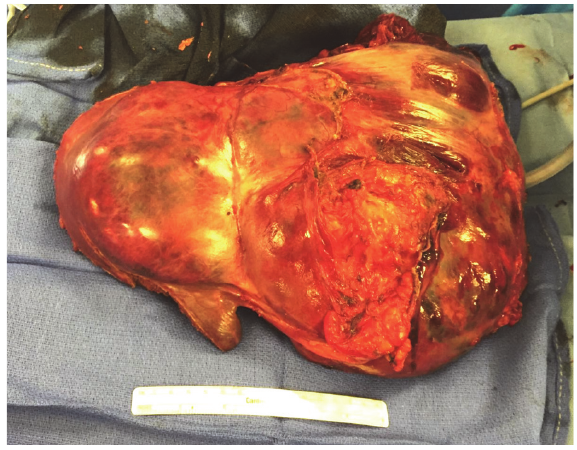
Figure 5: Resection specimen.